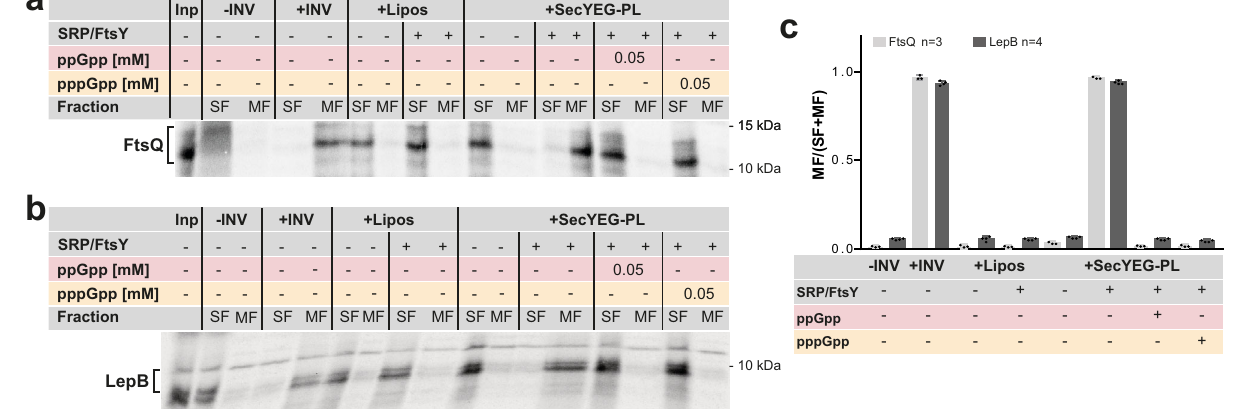
Fig. 2 Co-translational membrane targeting of ribosome-nascent chains (RNCs) is inhibited by (p)ppGpp. a and b RNCs of the SRP substrates FtsQ ( a ) or LepB ( b ) were in vitro synthesized (input, Inp) and incubated with INV (inner membrane vesicles) or reconstituted SecYEG proteoliposomes (SecYEG- PL; 100 ng SecYEG µ L − 1 ). INV buffer and liposomes (lipos) served as a control. When indicated, puri fi ed SRP and FtsY (20 ng µ L − 1 each) and ppGpp or pppGpp (50 µ M fi nal concentration) were present during incubation. Samples were then subjected to fl oatation gradient centrifugation and the membrane fraction (MF) and soluble fraction (SF) were were separated and analyzed by SDS-PAGE and autoradiography. Uncropped images are shown in